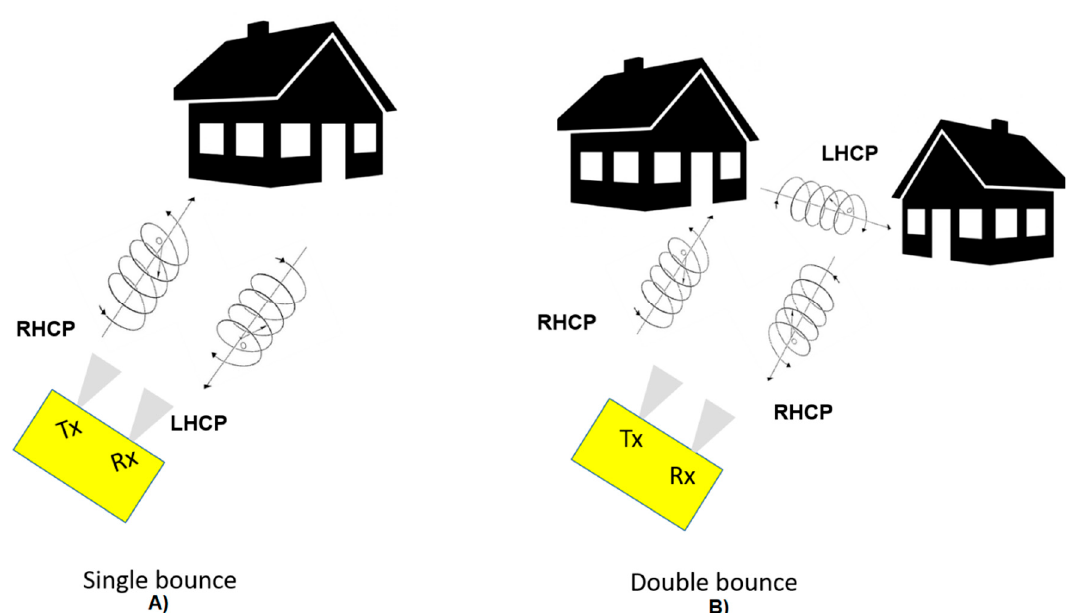
Figure 1. Single ( A ) and double ( B ) bounce effect on circularly polarized signal. RHCP: right-handed circular polarization, LHCP: left-handed circular polarization.